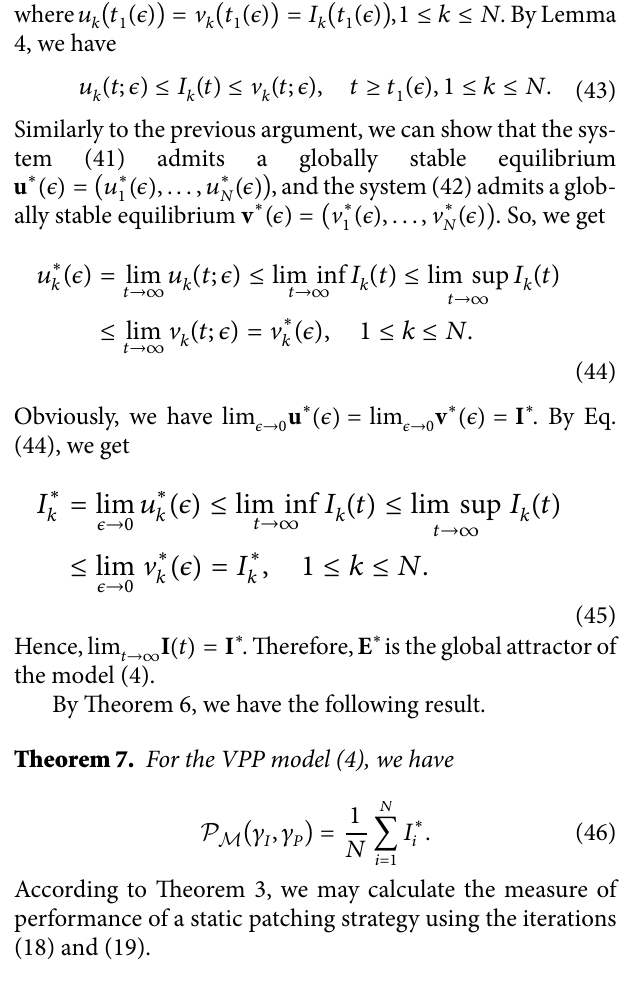
Figure 3: A synthetic scale-free network